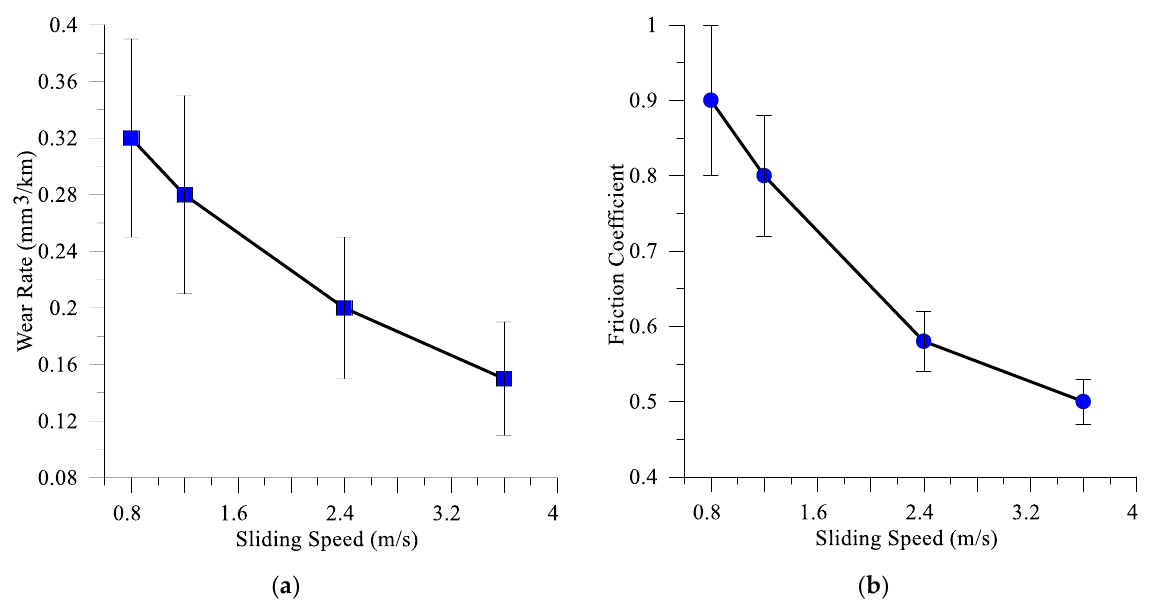
Figure 3. Wear rate ( a ) and coefficient of friction ( b ) vs. sliding speed for M2/W coating rubbed against the AISI 52 , 100 counterbody.